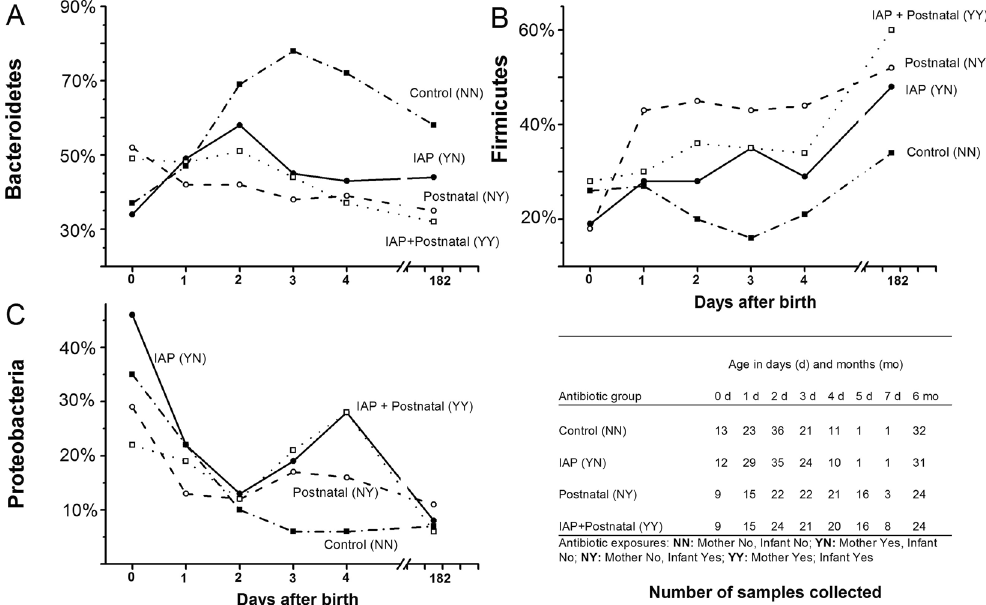
Figure 2. Dynamics of the developing intestinal microbiome of vaginally delivered infants according to perinatal antibiotic exposure during the whole study period. The mean relative abundance of three main bacterial phyla are presented: Bacteroidetes ( A ), Firmicutes ( B ), and Proteobacteria ( C ). The table presents the number of samples and study groups (NN, YN, NY and YY). The statistical comparisons using the data from the whole study period were performed using linear mixed model (P values in the text).